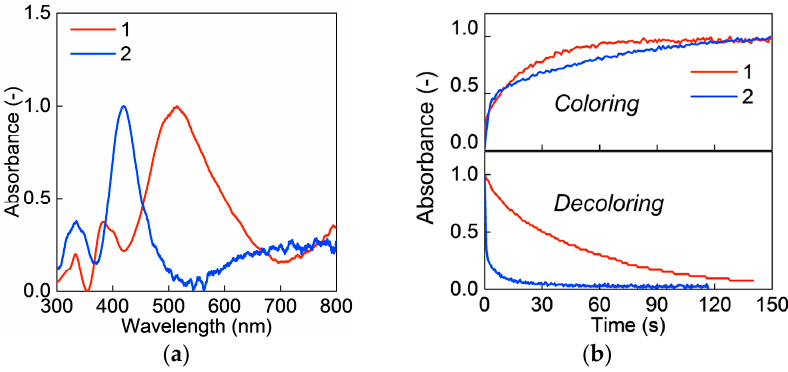
Figure 4. ( a ) UV-Vis spectra for the viologen polymers with cation states. ( b ) Response rate for coloring/decoloring (absorbance at 520 and 420 nm for 1 and 2 , respectively). Electrolyte solution was 35 mM EMIM TCB in 5CB.